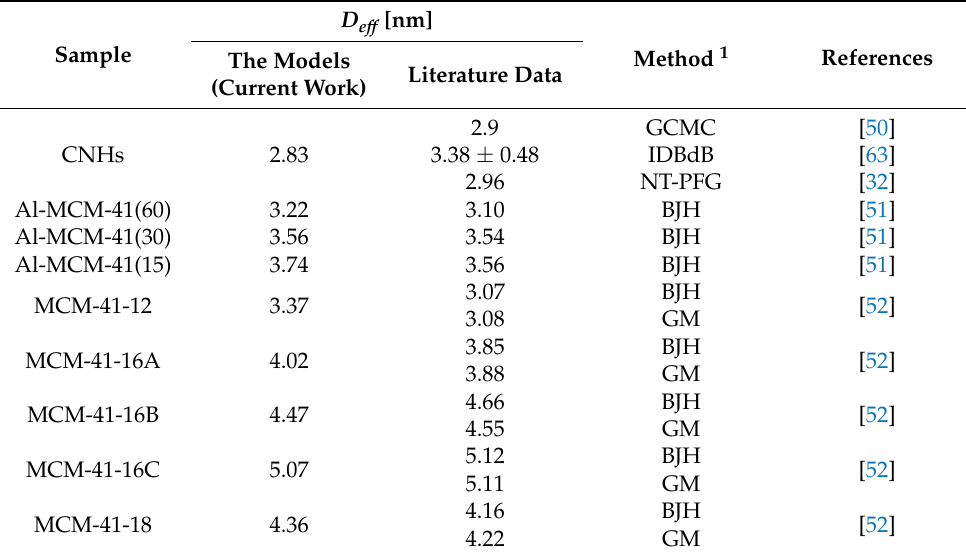
Table 1. The comparison of effective pore diameters for all the studied samples calculated from Equation (2) and the best-fit parameters obtained from the fitting of N 2 adsorption isotherms by theoretical models and the values obtained from more sophisticated methods published by others. D eff Sample